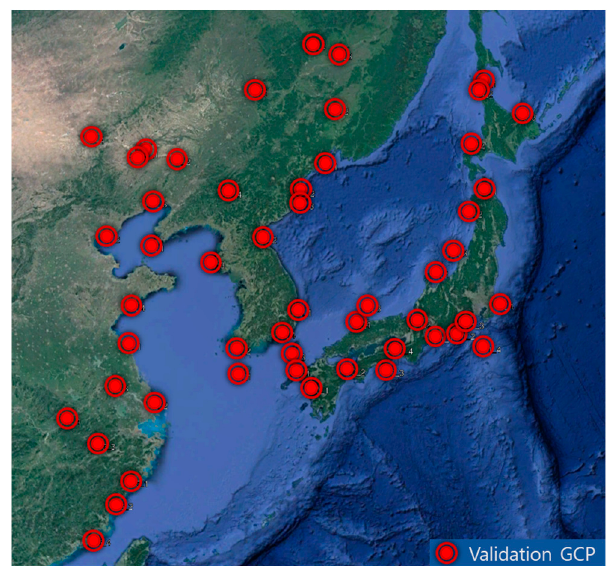
Figure 11. Experimental data (GOCI Level 1A).